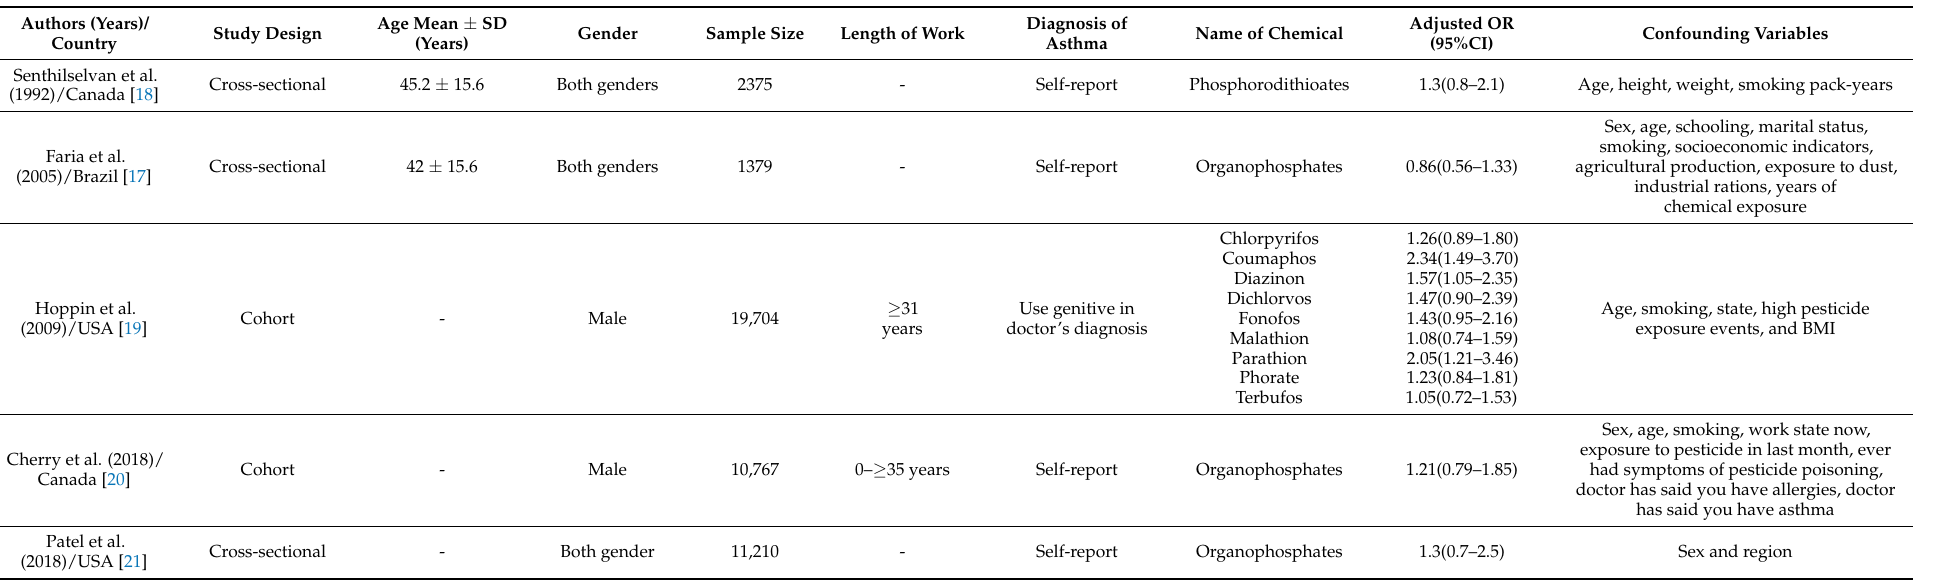
Table 1. The characteristics of studies evaluating the association between exposure to organophosphates and asthmatic symptoms.